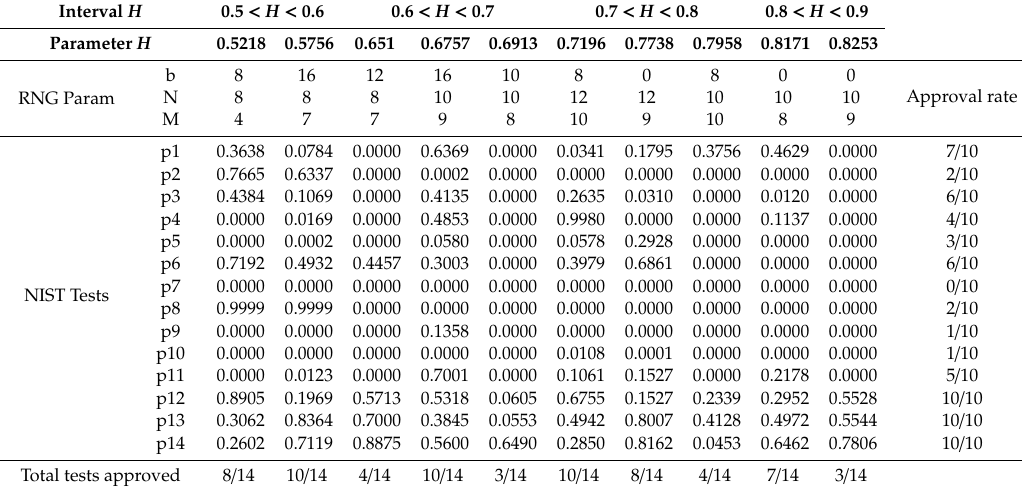
Table 2. Results table for the system